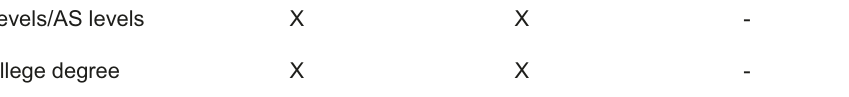
discovery rate. + and – indicate the direction of the coef fi cient for phenotypes associated with Alzheimer ’ s disease using two-sample MR. X represents associa- tions that were consistent with the